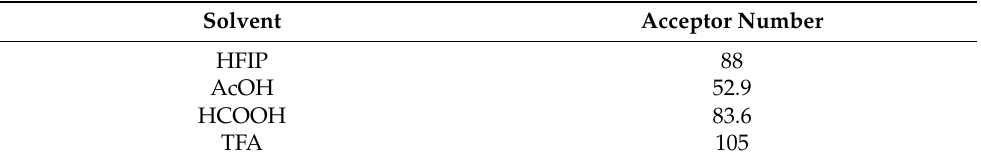
Table 1. Acceptor Number of some of the solvents considered in Atobe’s